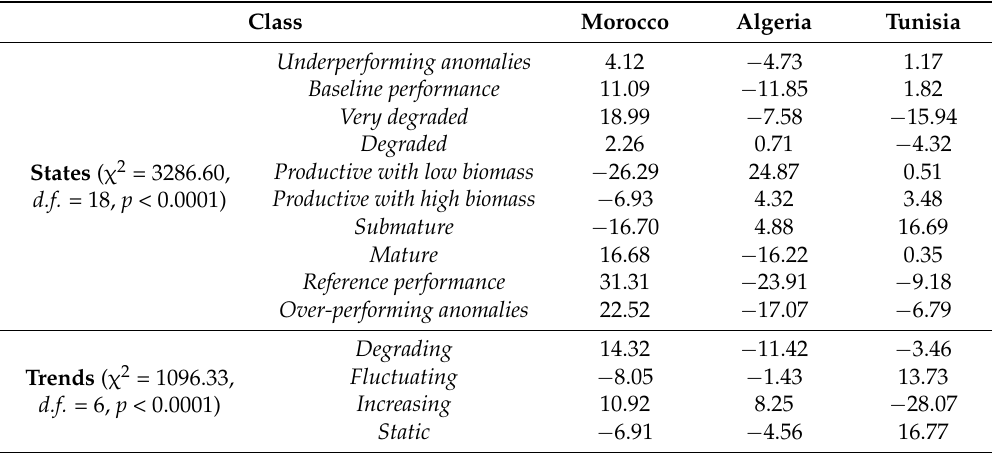
Table 1. Associations of land condition states, land condition trends and countries found using two chi-square tests. Inputs are adjusted residuals (corrected for sample size), expressing differences between observed frequencies and expected frequencies under the null hypothesis of a random distribution. Values are standard deviation units and can be tested as z-scores using a normal distribution. A threshold of ˘ 1.96 was used to determine